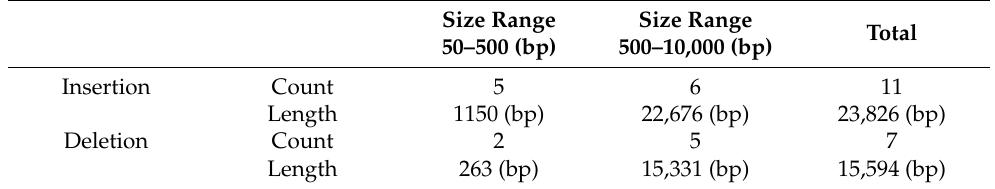
Table 2. The count and length of structural variations (SVs) between S. sclerotiorum strains PB4 and